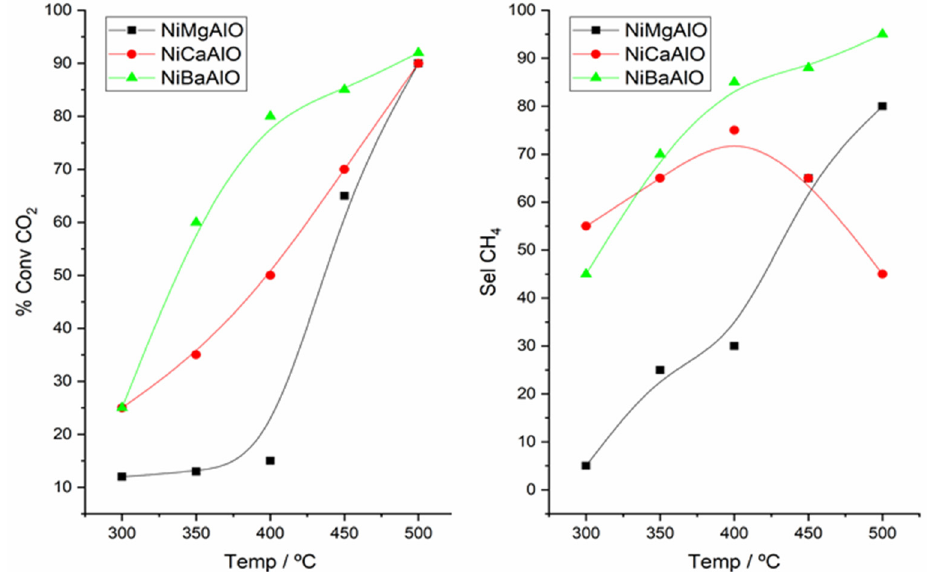
Figure 6. Conversion of CO 2 ( left ) and selectivity toward CH 4 ( right ) for NiBaAlO, NiMgAlO, and NiCaAlO calcined samples.